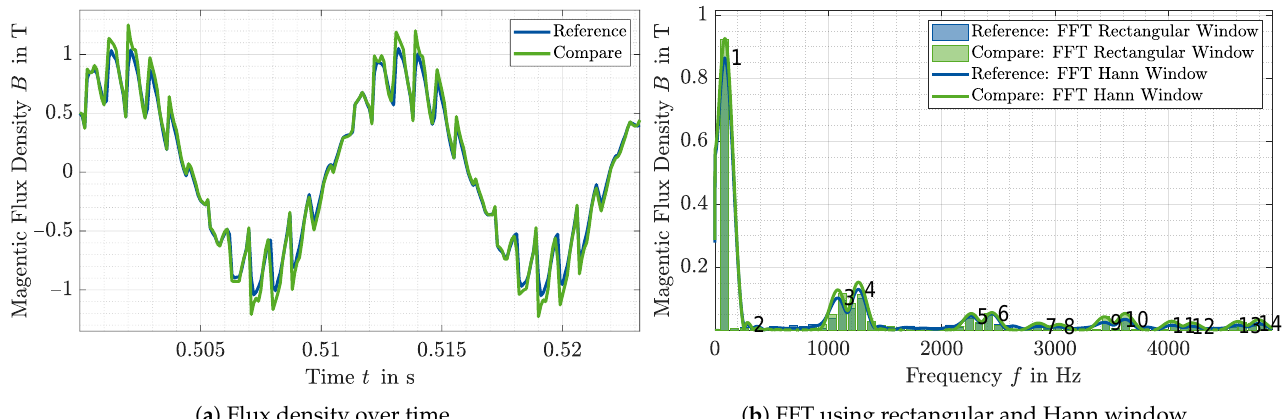
Figure 8. Magnetic air gap flux density simulated by two different